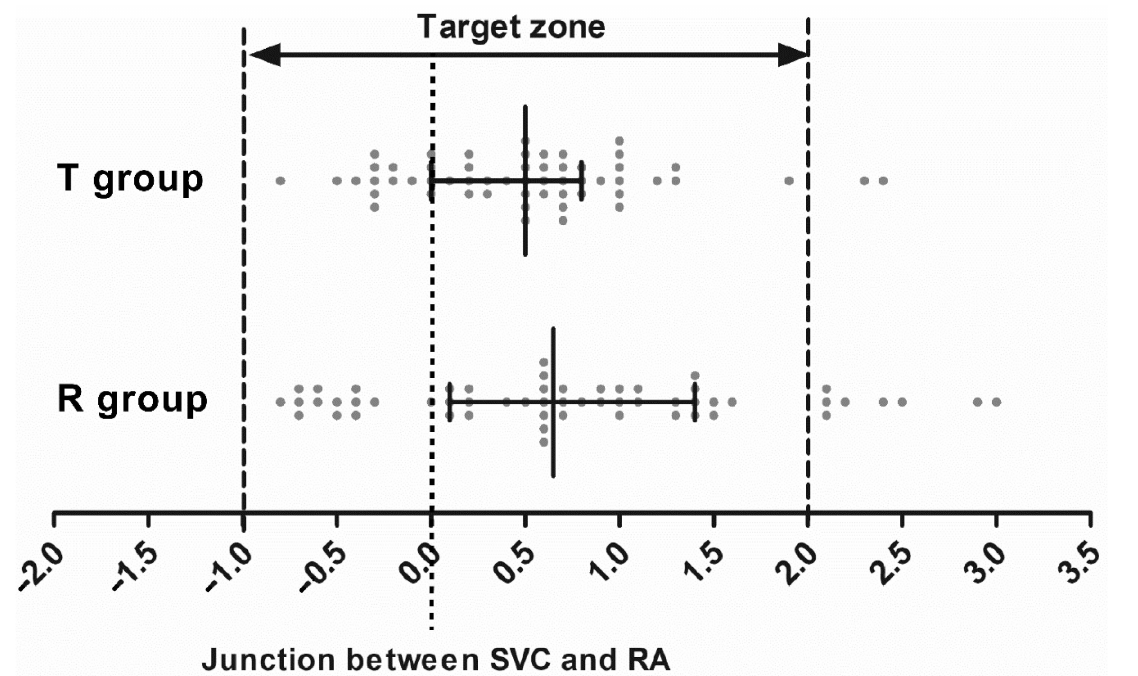
Figure 4. Scatter graph of catheter tip position within the target zone in both groups. Each circle represents an individual catheter tip position. Zero point refers to the junction between the SVC and the RA. Positive values indicate catheter tip position above the junction, and negative values indicate catheter tip position below the junction. Dashed lines indicate the upper and lower borders of the target zone. The solid vertical line indicates the median and the error bars indicate the interquartile range. Abbreviations: RA, right atrium; SVC, superior vena